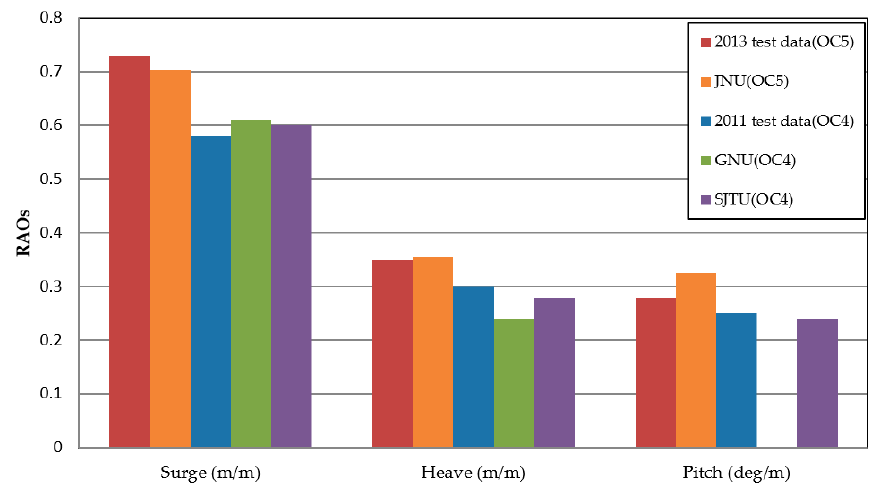
Figure 9. Comparison of response amplitude operators (RAOs) for surge, heave, and pitch.